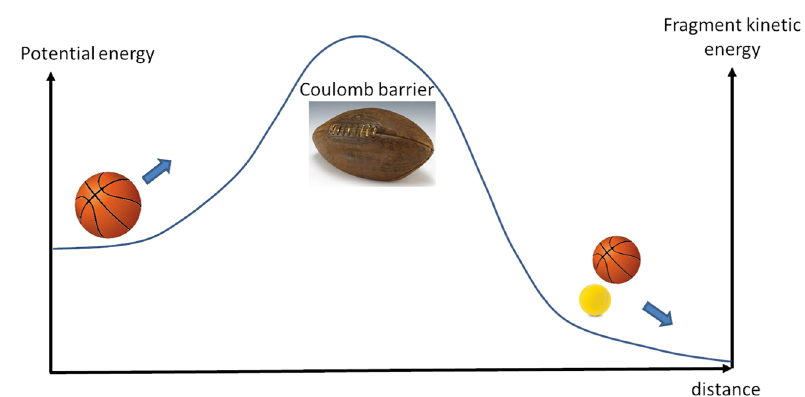
Fig. 2. – Nuclear potential energy as a function of the distance between the two